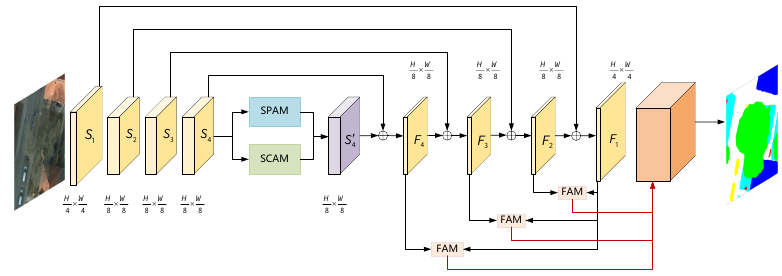
Figure 1. An overview of our proposed semantic segmentation network based on sparse self- attention and feature alignment (SAANet). H and W represent the height and width of the input image,